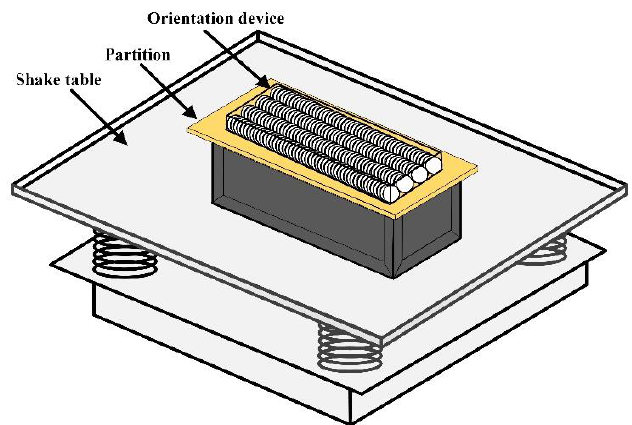
Figure 7. Preparation device for the aligned steel-fiber-reinforced concrete (ASFRC).